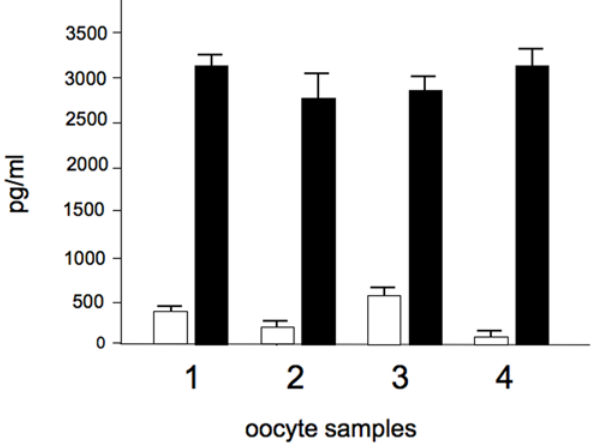
Figure 6. Comparison of levels of sICAM-1 (black boxes) and sHLA-G (white boxes) in supernatants of representative oocytes. For sHLA-G detection, covalent coupling of the anti-sHLAG antibodies to the carboxylated polystyrene microspheres (Bio-Rad, Hercules, CA, USA) was performed using the Bio-Plex amine coupling kit (Bio-Rad, Hercules, CA, USA). Bio-Plex assay was performed as elsewhere reported [2].